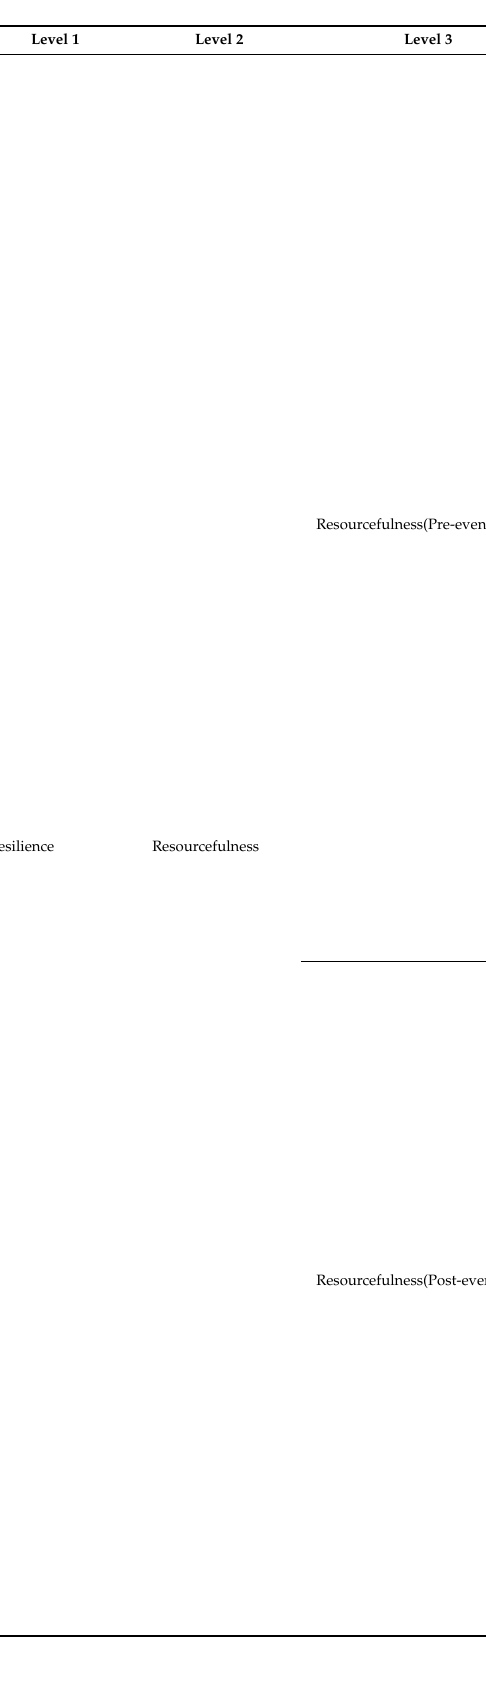
Table A3. Resilience indicators of